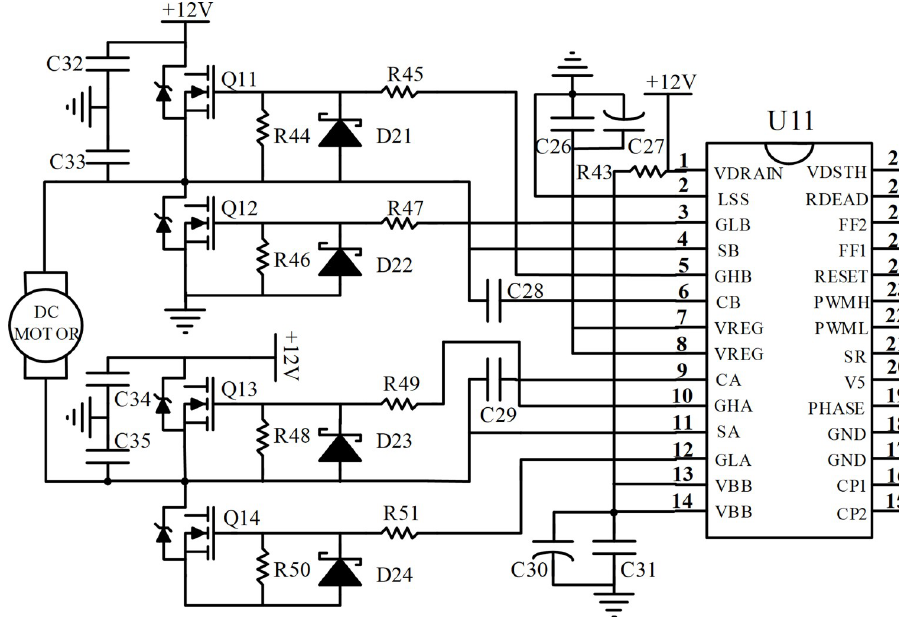
Fig 8. Schematic of current control.